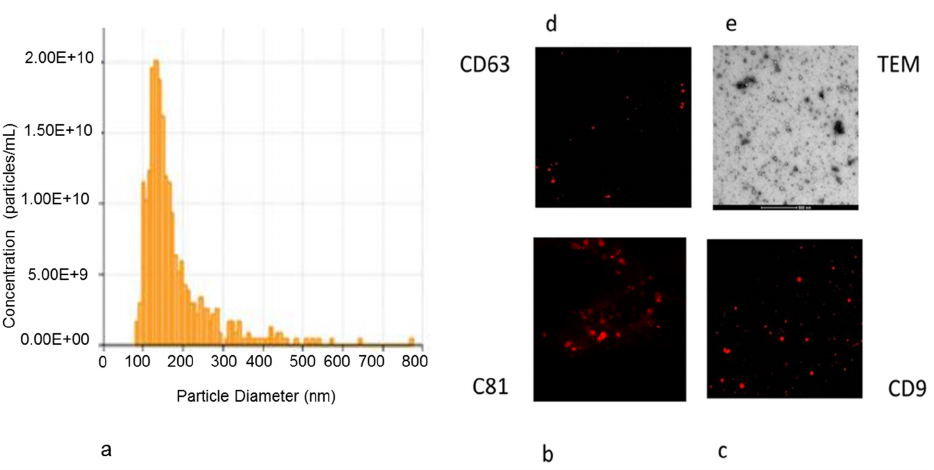
Figure 7. Characterization of exosomes derived from hAD-MSCs. ( a ) Size and concentration (by NanoSight analysis) of exosomes secreted by hAD-MSCs is reported in the graph. Nanoparticle characterization showed two populations of exosomes with peak diameter of 110 and 180 nm, respectively. ( b – d ) Immunohistochemistry analysis of the exosome surface markers CD9, CD 63,